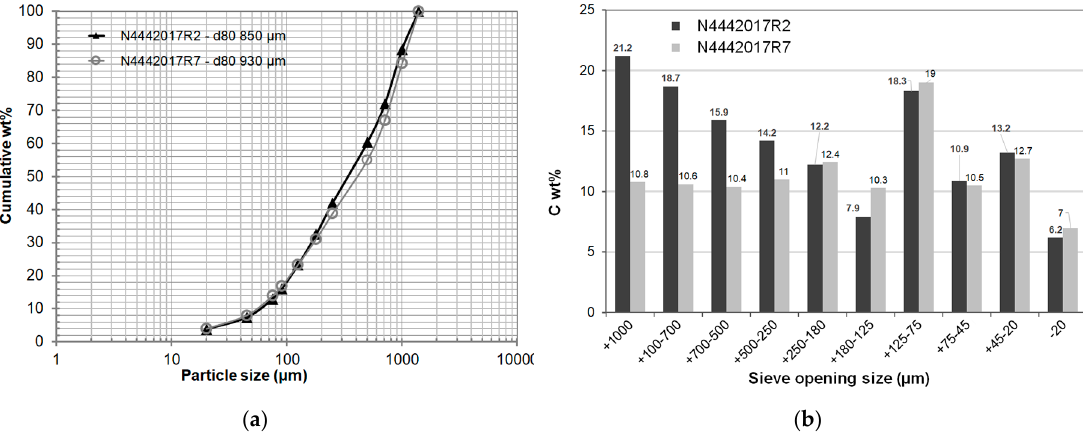
Figure 4. ( a ) Cumulative percentage against sieve sizes; ( b ) carbon content (%) of particle size distribution of graphite samples after crushing to particle sizes <1.4 mm (d80 = 850 and 930 µm for samples N4442017_R2 and N4442017_R7, respectively).